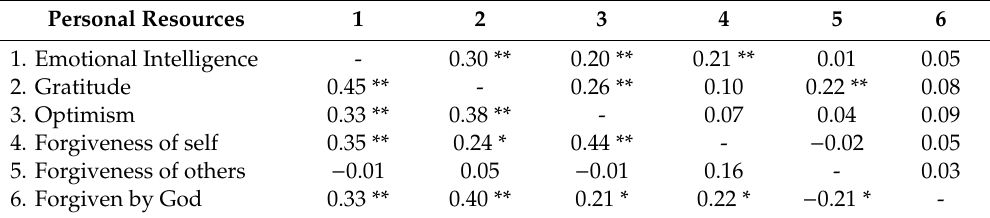
Table 1. Person intercorrelations between positive personal resources for non-depressive symptomatology group ( n = 162, above diagonal) and depressive symptomatology group ( n = 89, below diagonal).